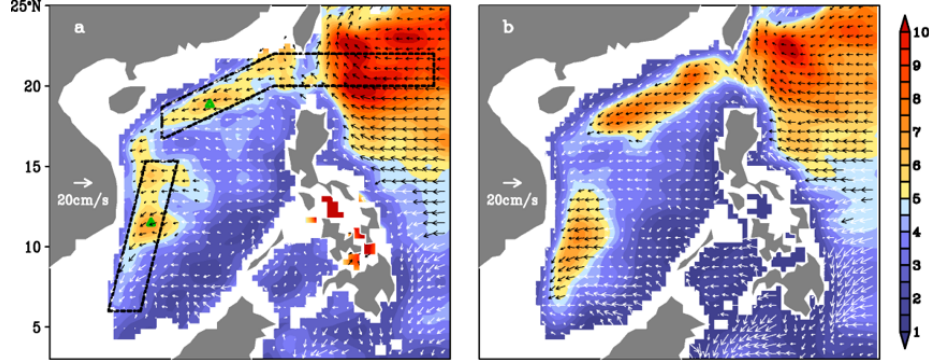
Figure 2. Annual mean standard deviation of sea level mesoscale signals (color shading, unit: cm) and propagation velocities of the signals (vectors) derived from (a) altimeter observations and (b) OFES (Ocean General Circulation Model for the Earth Simulator) simulations. Cited from Zhuang et al. (2010).